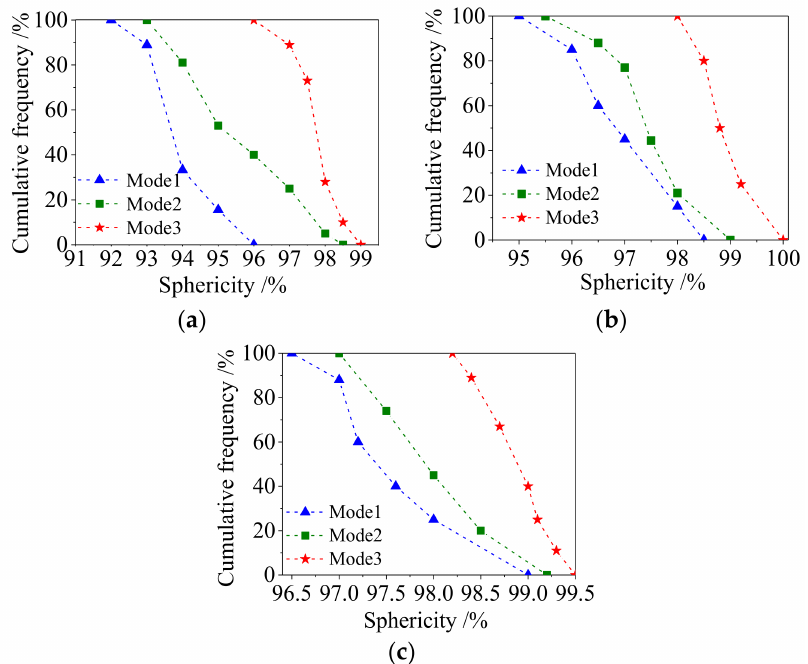
Figure 8. E ff ect of the curing modes on the sphericity. ( a ) ∆ ρ = 0.0068 g / cm 3 ; ( b ) ∆ ρ = 0.0044 g / cm 3 ; ( c ) ∆ ρ = 0.0004 g / cm 3